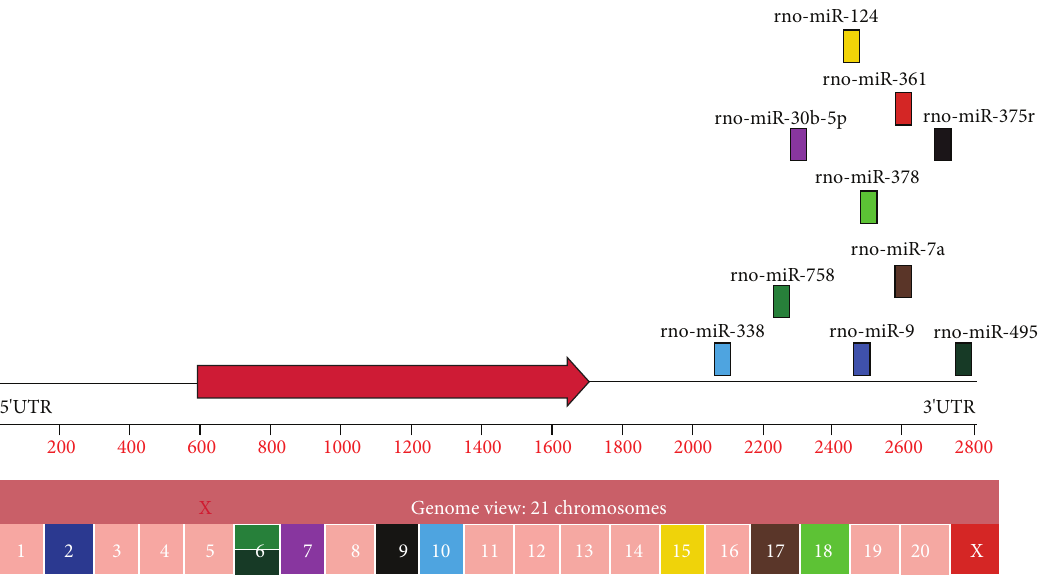
Figure 3: The 3’UTR of the intronless Forkhead Box E1 gene ( foxe 1), located on chromosome 5 ( X ), is targeted by 10 miRNAs (rectangles with different colors). All the miRNAs are localized on different chromosomes in the rat genome (colored chromosome corresponds to miRNAs of the same color). The 10miRNAs are upregulated in response to retinal IR-injury in rat retinal ischemic model while the expression level of foxe 1 is